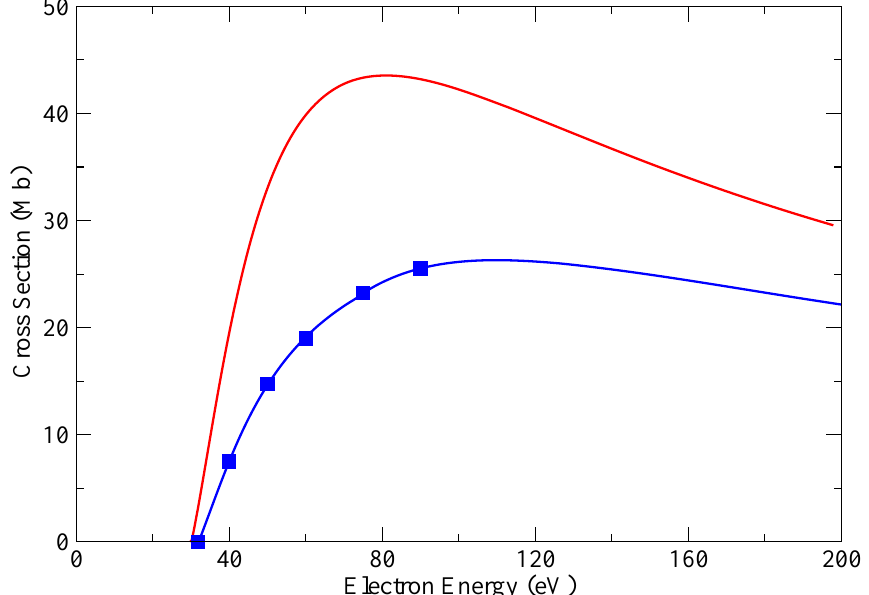
Figure 2. Electron ionization of the 4 s subshell of Kr Solid line (red): distorted-wave method, solid line with squares (blue): time-dependent close-coupling method (1.0 Mb = 1.0 × 10 − 18 cm 2